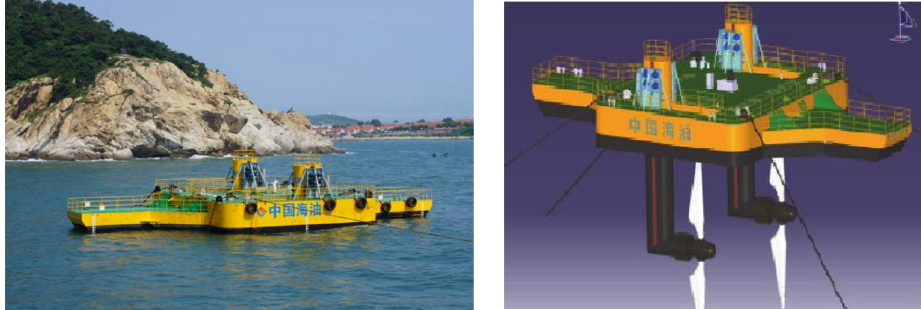
Figure 7. “Haineng II”—2 × 100 kW floating horizontal-axis TCPGS. Reproduced from [28,29].